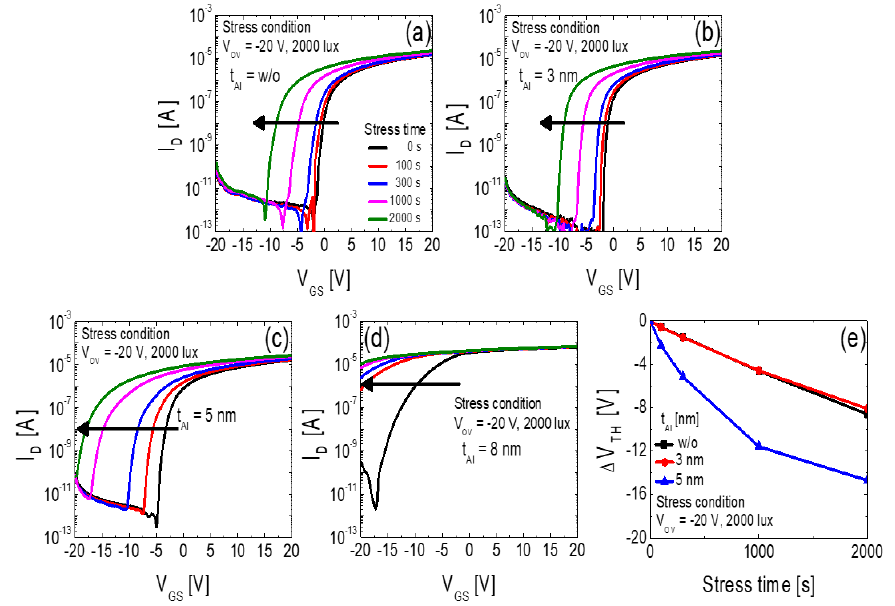
Figure 4. Time dependence of the transfer curves for IGTO TFTs ( a ) without and with ( b ) 3, ( c ) 5, and ( d ) 8 nm thick Al capping layers, under a negative bias illumination stress (NBIS) of V OV = −20 V and a white light (luminance: 2000 lx). ( e ) ∆ V TH obtained from IGTO TFTs without and with 3 and 5 nm thick Al capping layers after each NBIS time.